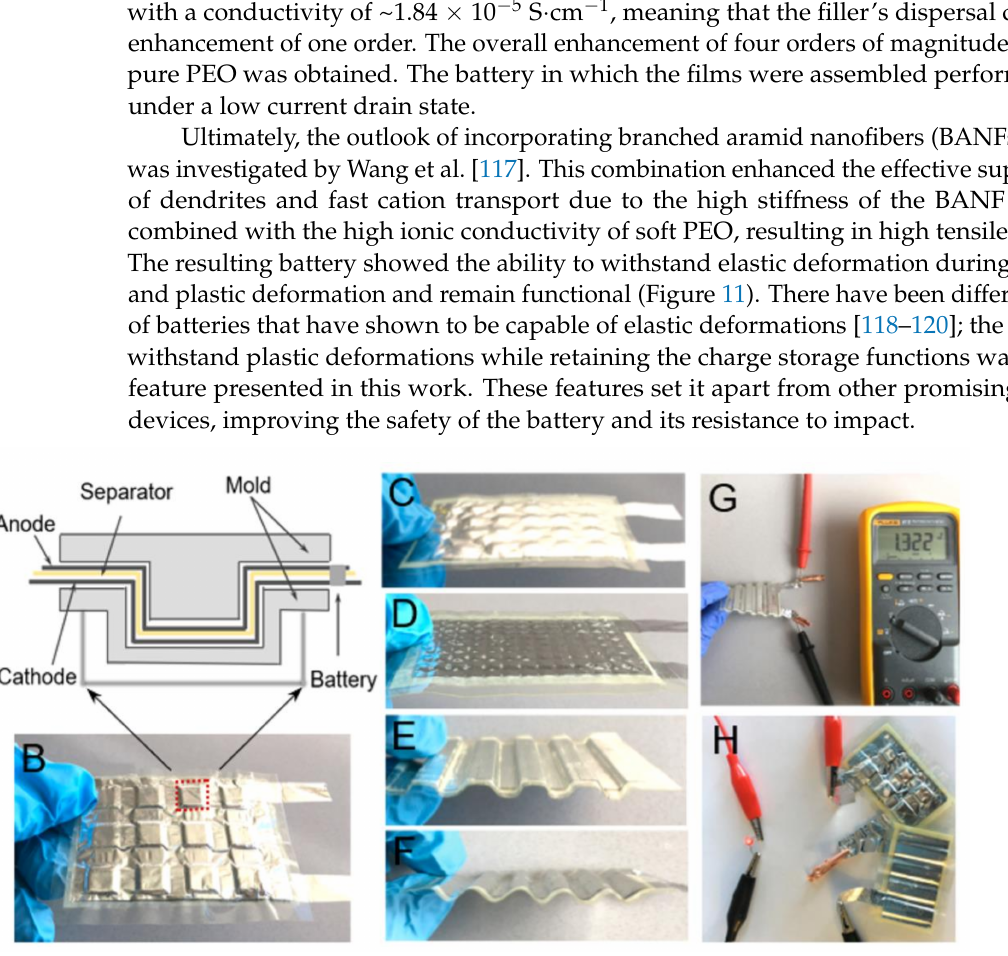
Figure 11. ( A ) Schematic of the mold used for plastic deformation studies. ( B − F ) Different plastically deformed shapes of Zn battery with solid-state biomimetic electrolyte. ( G ) The open-circuit voltage of Zn/PZB-931/ γ -MnO 2 battery with square wave shape plastic deformation. ( H ) LED light powered by the two serial structural batteries. Reproduced with permission from ACS Nano, 13, Wang et al., Biomimetic Solid-State Zn 2+ Electrolyte for Corrugated Structural Batteries, 1107–1115, 2019